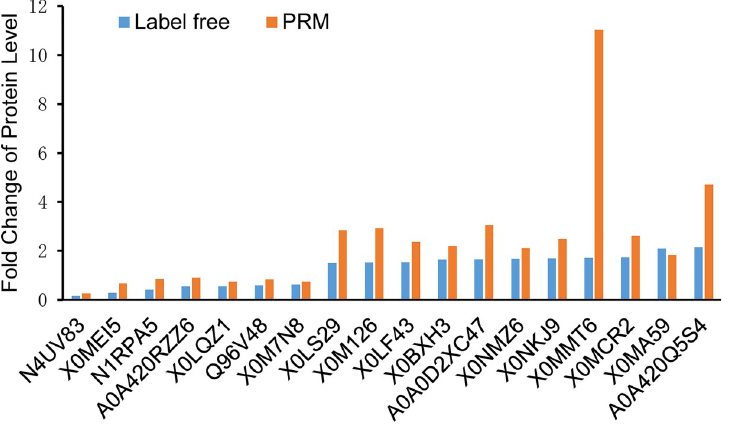
Fig 6. PRM analysis for 18 selected differentially expressed